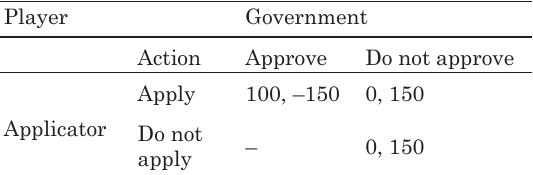
table 2. applying for economically affordable house: unqualified applicator ( Type